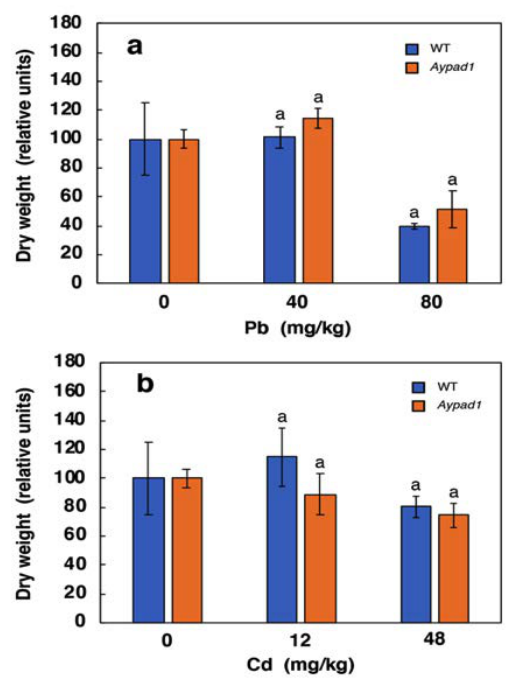
Figure 2. Influences of Pb (a) and Cd (b) on the growth of wild- type (WT) and Aypad1 gametophytes. Small fragments of the gametophytes were precultured for 10 days and then cultured at the indicated Pb or Cd concentrations. After 33 days of cultiva- tion, the gametophytes were dried and weighed. The data are shown as relative units based on the values without Pb and Cd. The different letters indicate significant differences determined by the Student's t-test (p ≤ 0.05) within the designated days. The error bars indicate the SEs ( n =3–5).